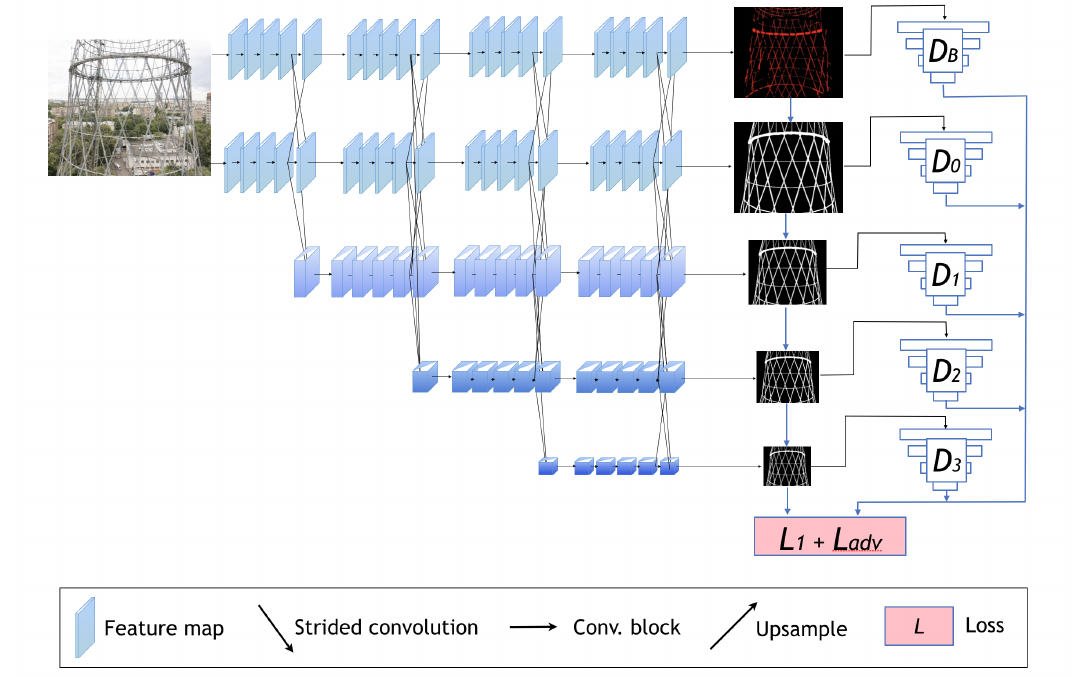
Figure 7. Overview of the WireNetV2 model.